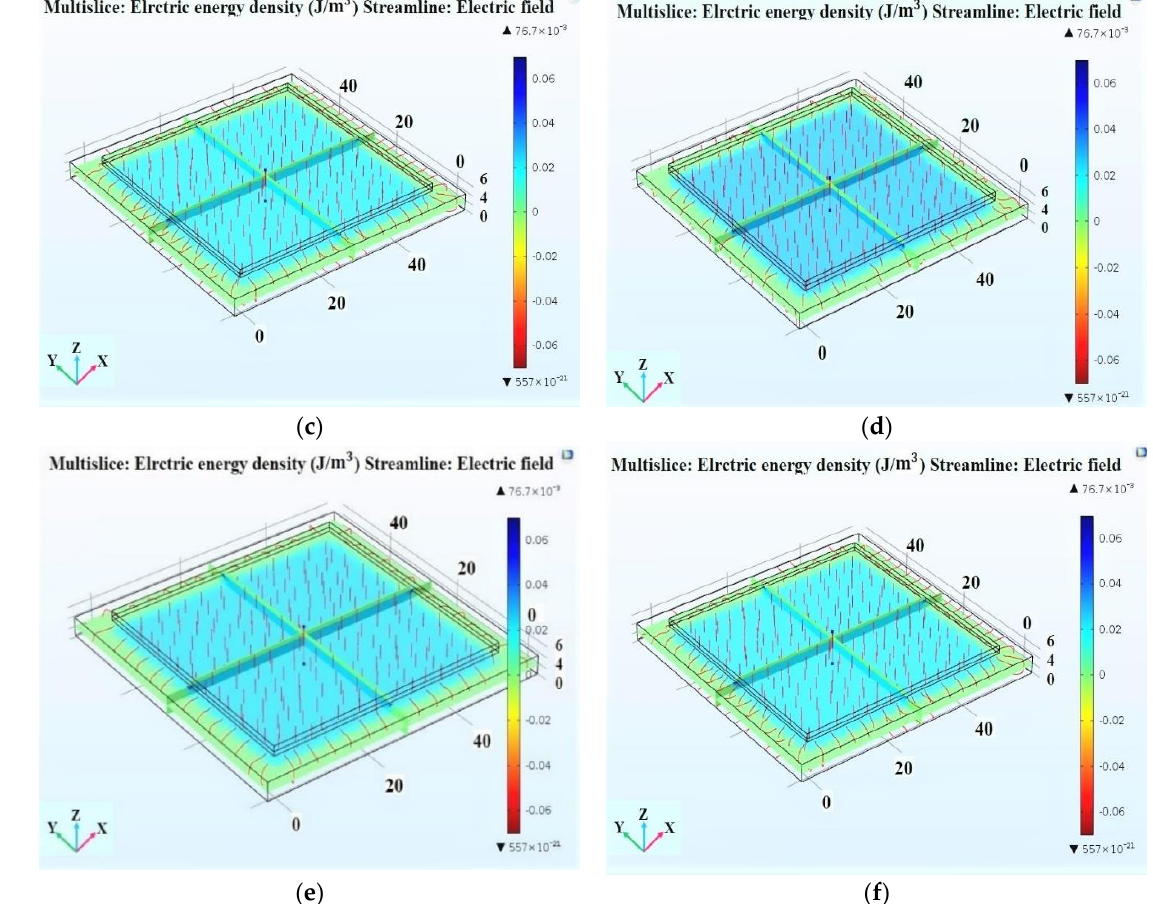
Figure 18. ( a ) Capacitor plate arrangement with ceramic thickness (d = 0.5 mm). ( b ) Capacitor plate arrangement with ceramic thickness (d = 0.6 mm). ( c ) Capacitor plate arrangement with ceramic thickness (d = 0.7 mm). ( d ) Capacitor plate arrangement with ceramic thickness (d = 0.8 mm). ( e ) Capacitor plate arrangement with ceramic thickness (d = 0.9 mm). ( f ) Capacitor plate arrangement with ceramic thickness (d = 1 mm).